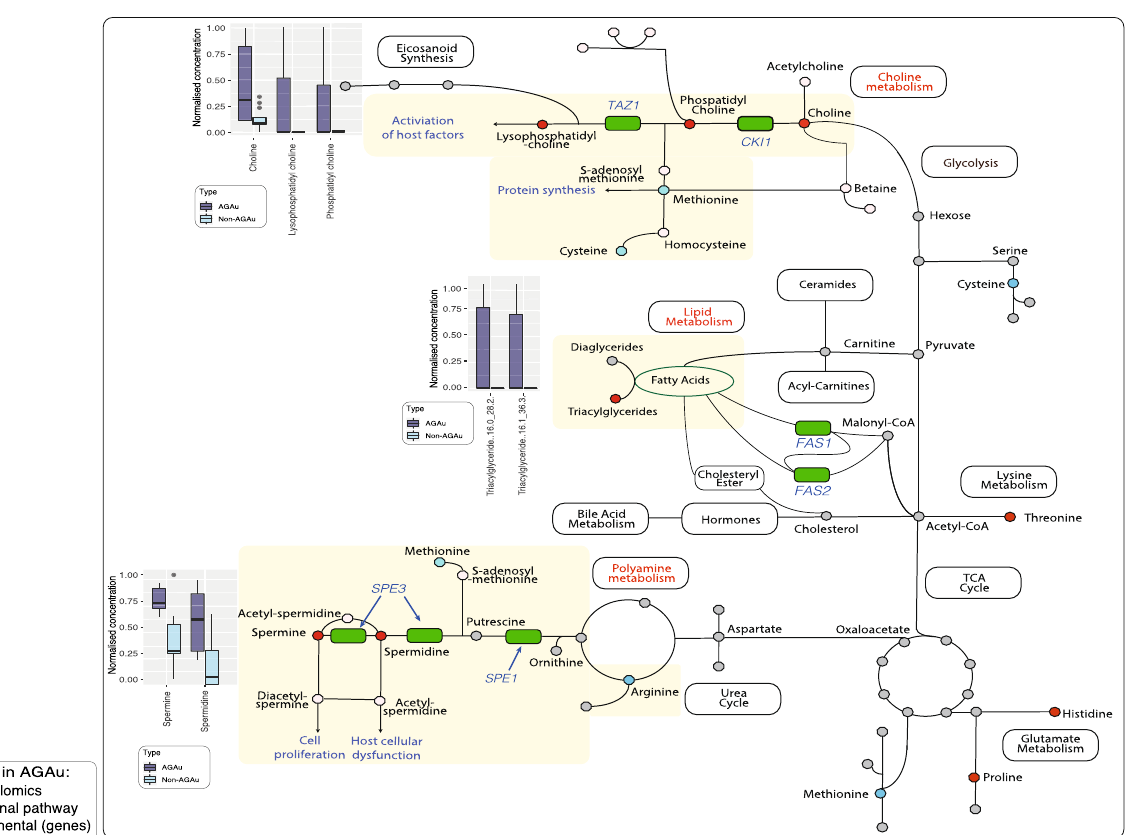
Fig. 4 Global map metabolism in AGAu Candida strains. Enriched pathways observed in functional annotation and further validated by metabolomics with key metabolites markedly signi fi cant. The boxplots indicate metabolomics of individual metabolites in corresponding pathway (Wilcoxon rank-sum test, P value < 0.05, median middle line IQR and whiskers 1.5× IQR). *Colour in pathway red identify signi fi cant metabolites, blue indicate signi fi cant pathway enrichment and green denotes validation with gene